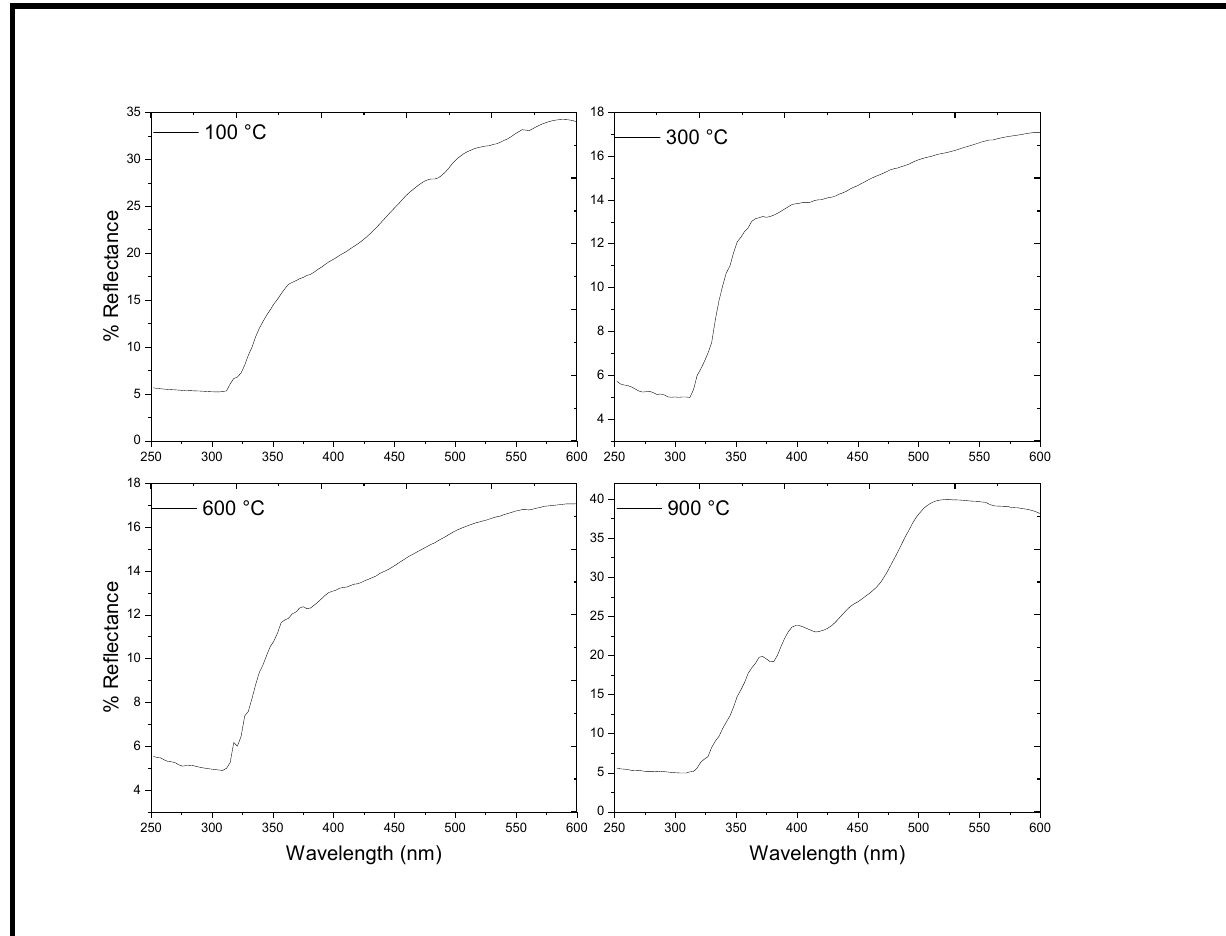
Figure 3. DRS spectra of the NiO ‐ SnO 2 NCs calcined at the indicated temperature. The transmittance edge obtained for NiO ‐ SnO 2 NCs calcined at 100, 300, 600, and 900 °C were 324, 325, 326, and 345 nm, respectively. All the samples show significant absorption in the visible region and a blue shift was seen with increasing calcination temperatures. The band gap energy of NiO ‐ SnO 2 NC calcined at 100, 300, 600, and 900 °C , determined through Tauc plot, were 3.31, 3.30, 3.27, and 3.24 eV, respectively (Figure 4). With an increase in the calcination temperature, the energy band gap decreases, which might be due to dehydration and the formation of compacted large particles [36].